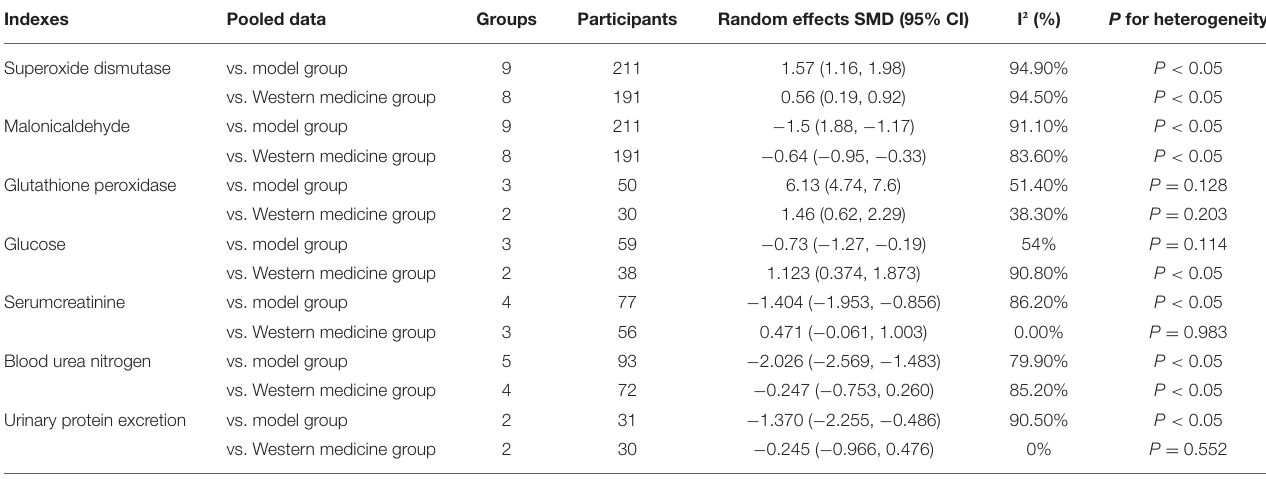
TABLE 2 | Summary of quantitative data analysis.